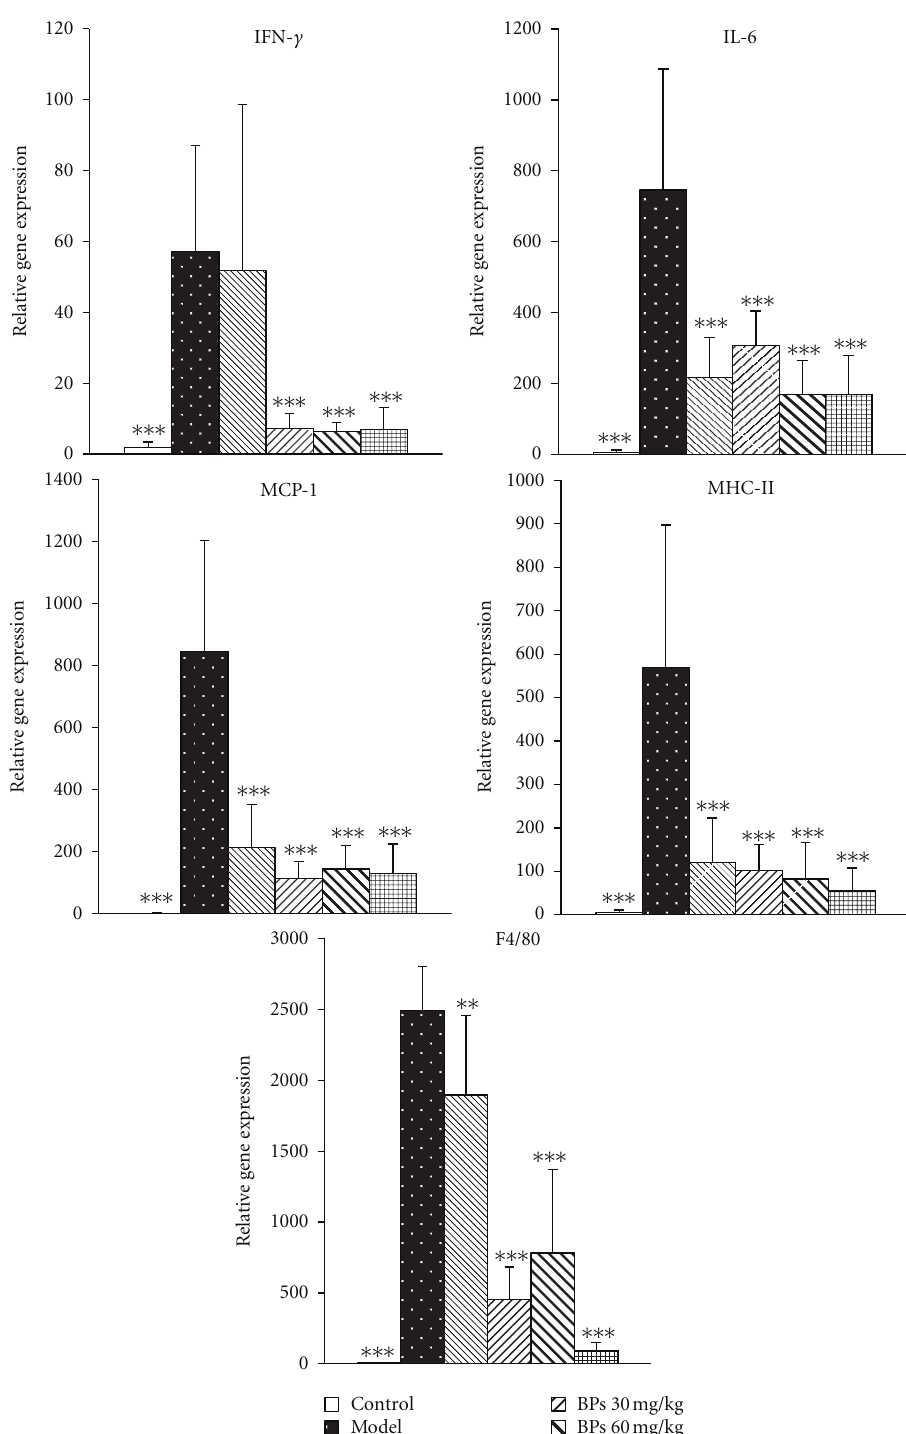
Figure 6: IFN- γ , IL-6, MCP-1, MHC-II, and F4/80 mRNA expression in the kidney from MRL-lpr mice. The mRNA expression of IFN- γ , IL-6, MCP-1, and MHC-II in the kidney was prepared from the BALB/c mice (control) and MRL-lpr mice administered vehicle solution (model), 15, 30, and 60 mg · kg − 1 · day − 1 BPs, or 5mg · kg − 1 · day − 1 prednisone. The levels of mRNA were analyzed by real-time PCR; GADPH was shown as the loading control. Each data point represented the mean of individual mouse in three independent experiments. Values were presented as means ± S.D. ratio of IFN- γ , IL-6, MCP-1, MHC-II, and F4/80 mRNA to GADPH mRNA ( n = 6). ∗ P < 0 . 05, ∗∗ P < 0 . 01, ∗∗∗ P < 0 . 001 compared with vehicle-treated model group, tested by ANOVA and Fisher’s